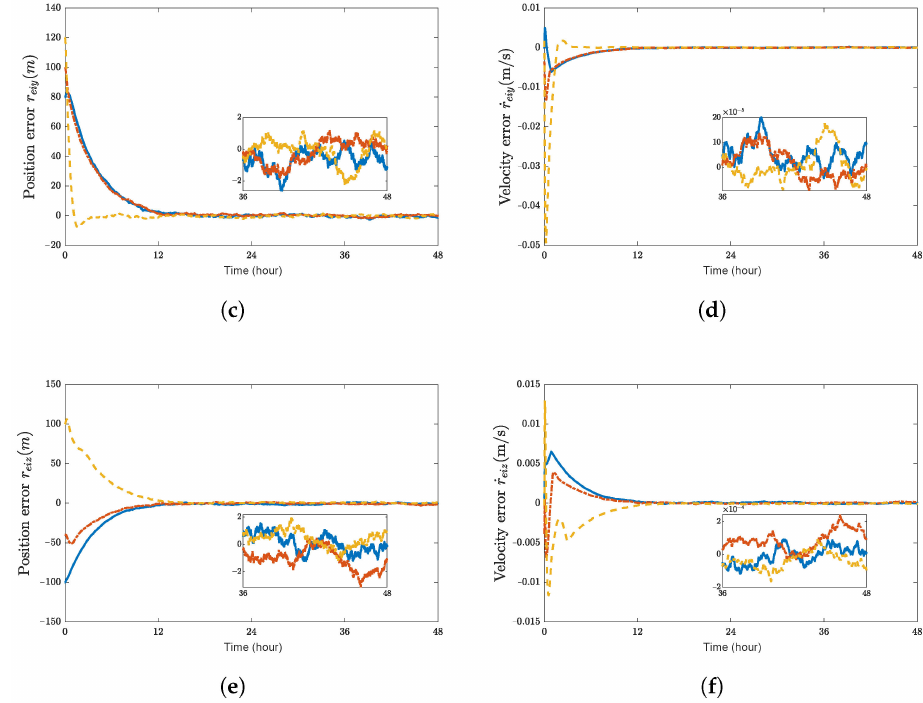
Figure 1. Position errors and velocity errors of spacecraft SC1 ∼ 3. ( a ) position error r eix (m); ( b ) velocity error ˙ r eix (m/s); ( c ) position error r eiy (m); ( d ) velocity error ˙ r eiy (m/s); ( e ) position